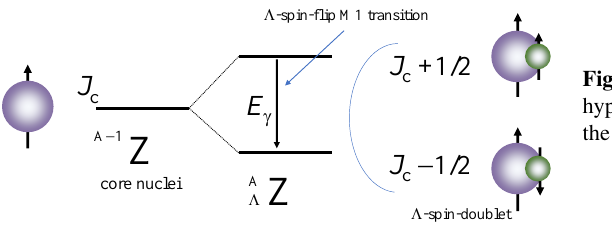
Figure 5. Schematic drawing of the hypernuclear spin-doublet states and the (cid:3) -spin-flip M1 transition.